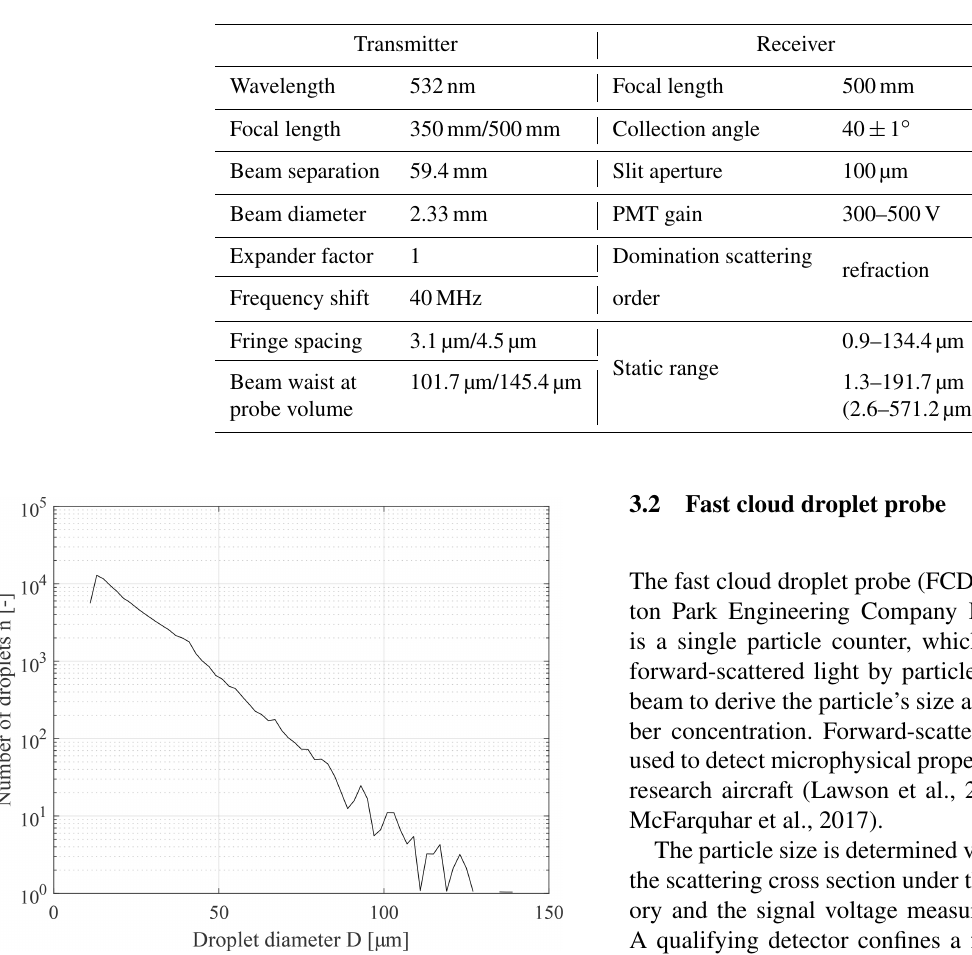
Table 1. Characteristic numbers of PDI setup Artium PDI-x00MD.